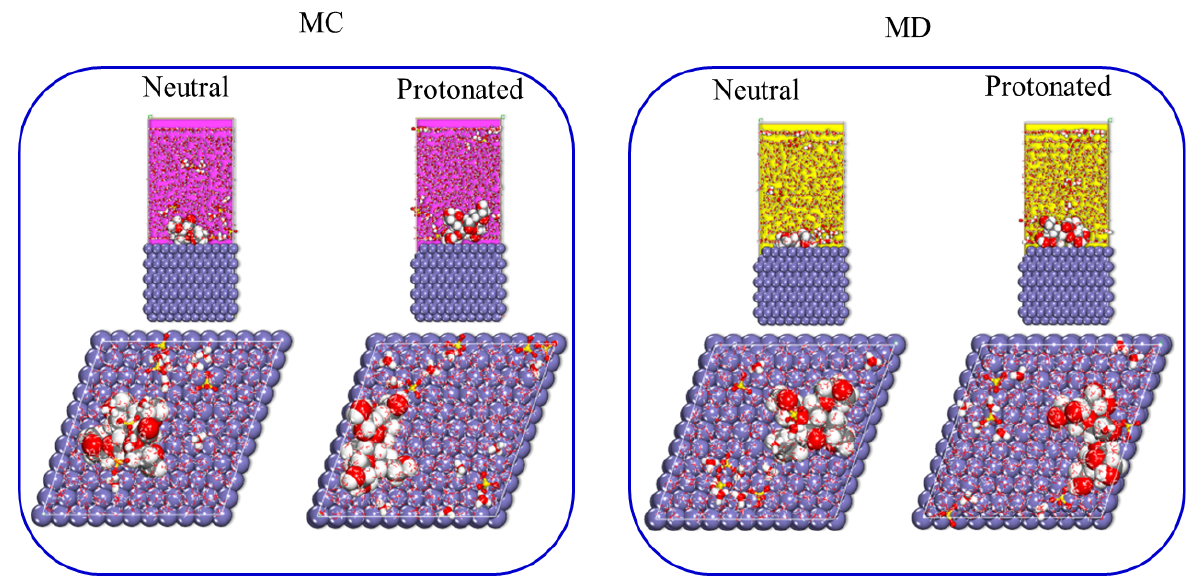
Figure 10. ( Left ): MC and ( Right ): MD poses the lowest adsorption configurations for inhibitory resin adsorption in the simulated aggressive environment on the Fe (110) area.